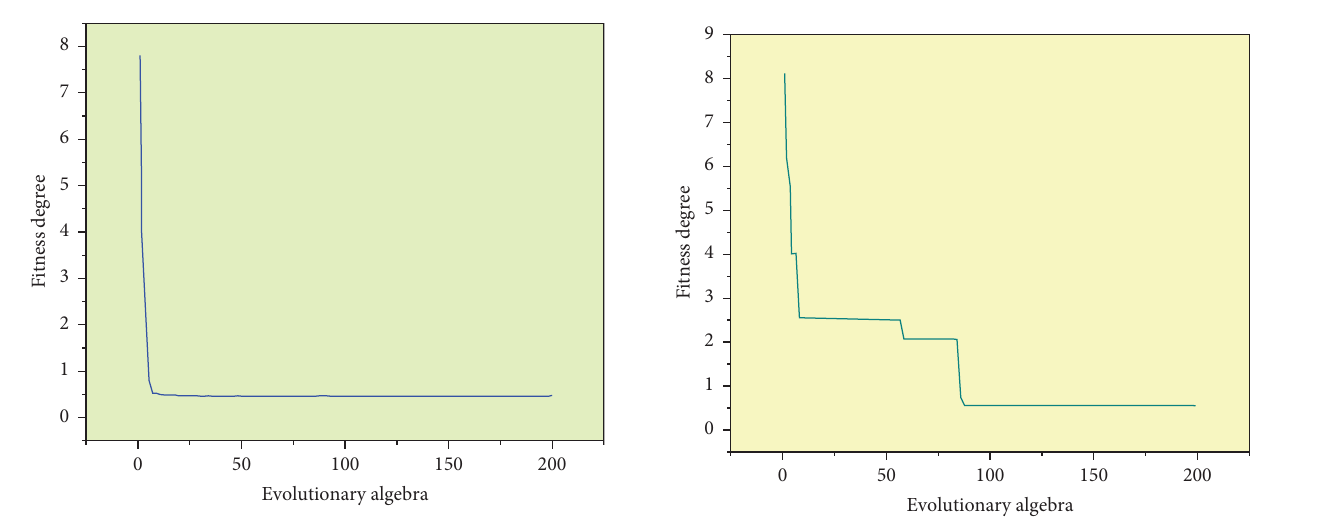
Figure 8: PSO algorithm